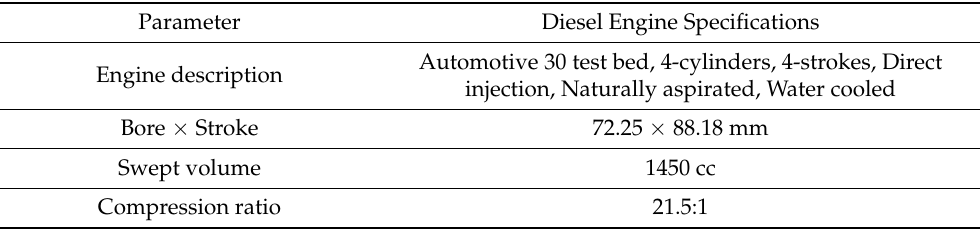
Table 1. Diesel engine